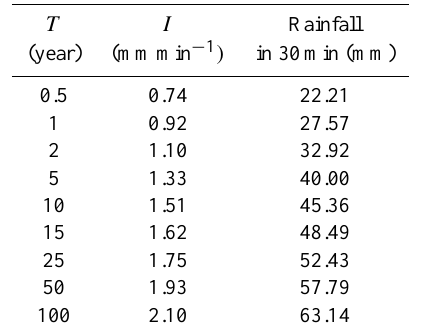
Table 4. Rainfall in 30 min calculated for different return periods for the city of Barcelona, based on the generalised IDF curves equa- tion.